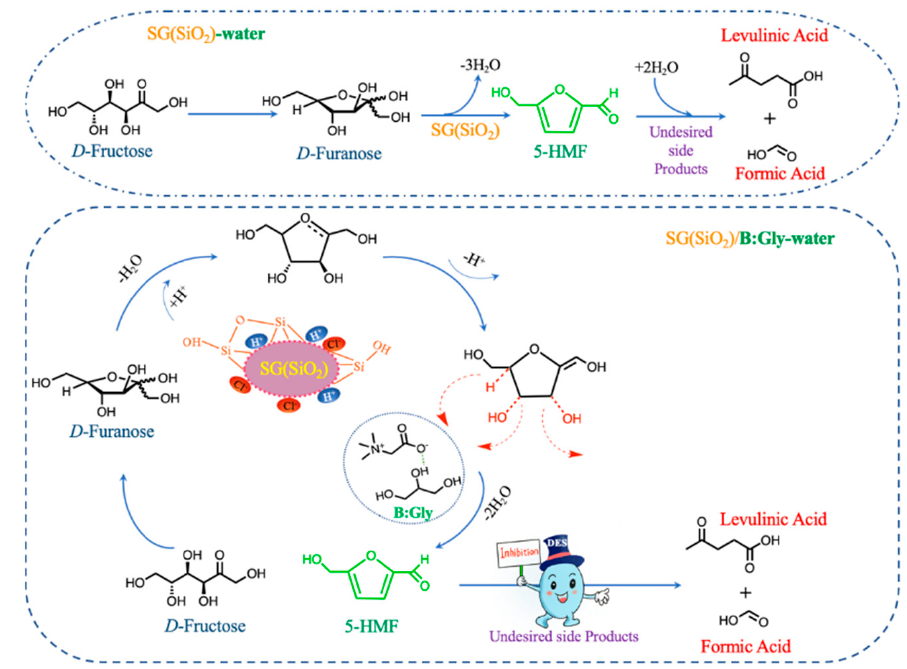
Figure 6. Possible mechanism for the dehydration of D -fructose.